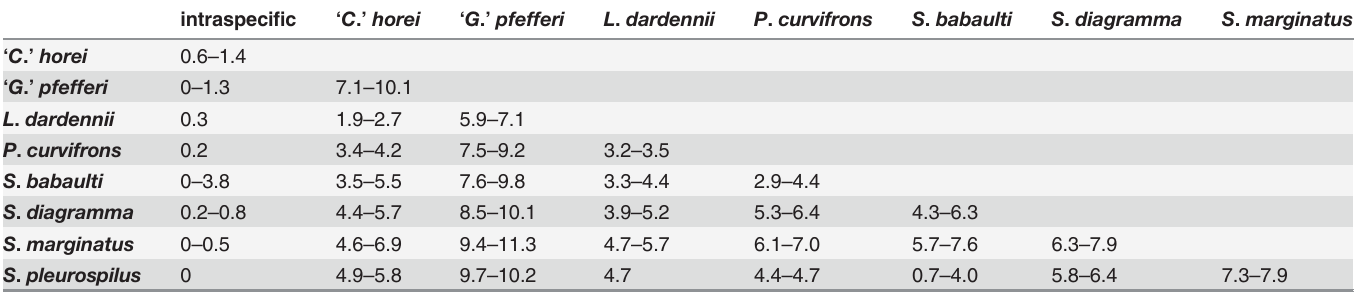
Table 8. Barcoding results for Pseudosimochromis , Simochromis and the other “ sediment dwelling ” tropheine